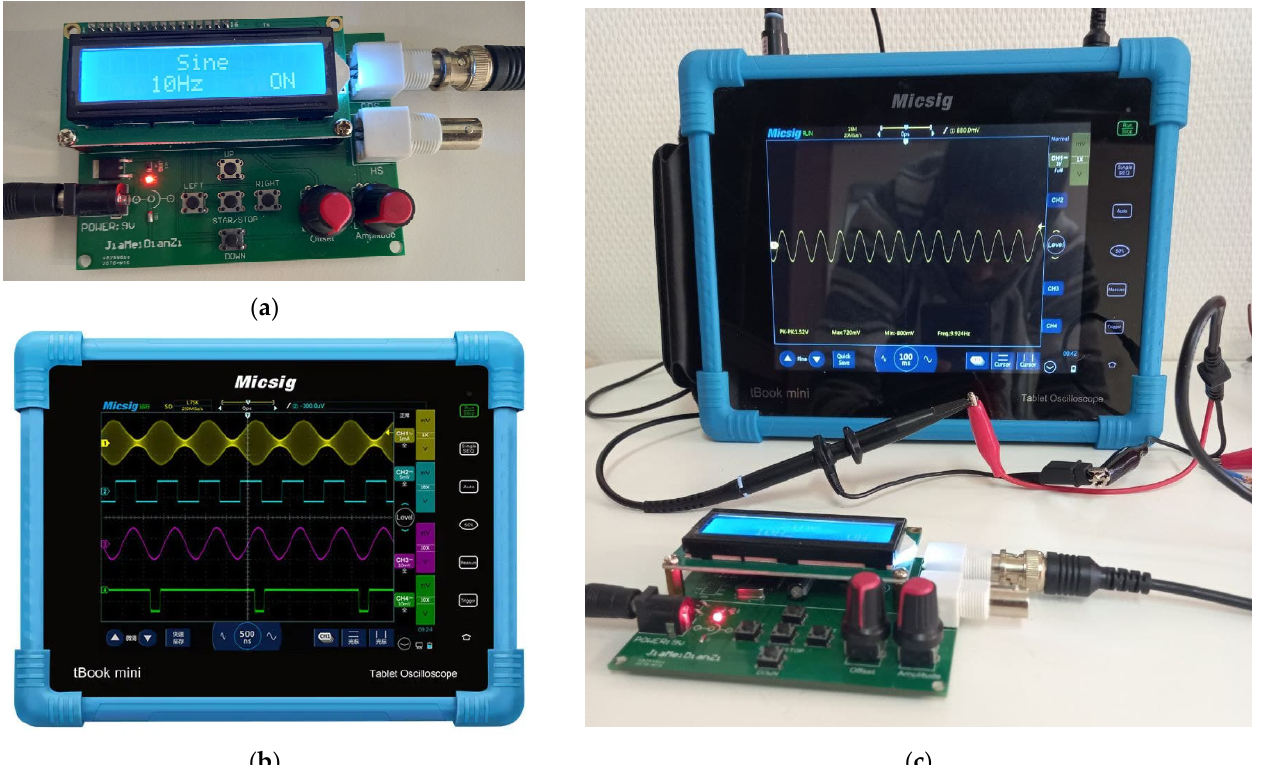
Figure 9. Synthetic sine wave generation: ( a ) function generator printing; ( b ) digital oscilloscope; and ( c ) synthetic sine wave generated by the function generator on a digital